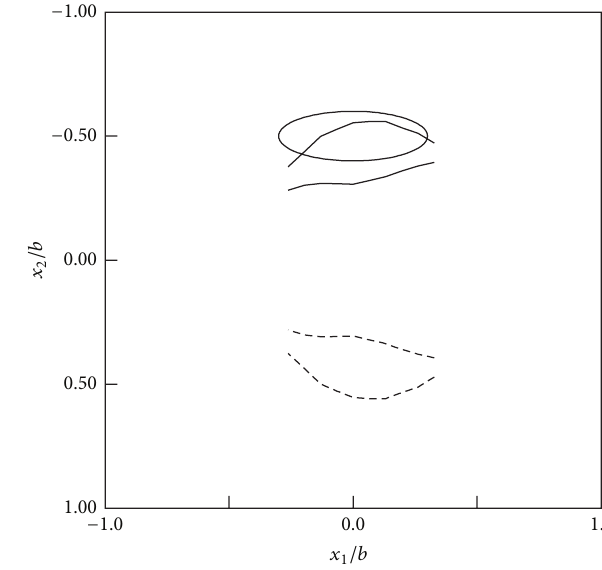
Figure 10: Reconstructed cavity with 𝑅 1 = 0.3𝑏 , 𝑅 2 = 0.1𝑏 , and ̃𝑥 = −0.5𝑏 . 2